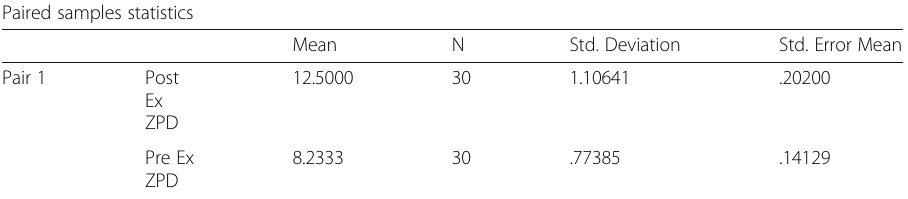
Table 7 Descriptive statistics of the experimental Group ’ s ZPD assessment Paired samples statistics